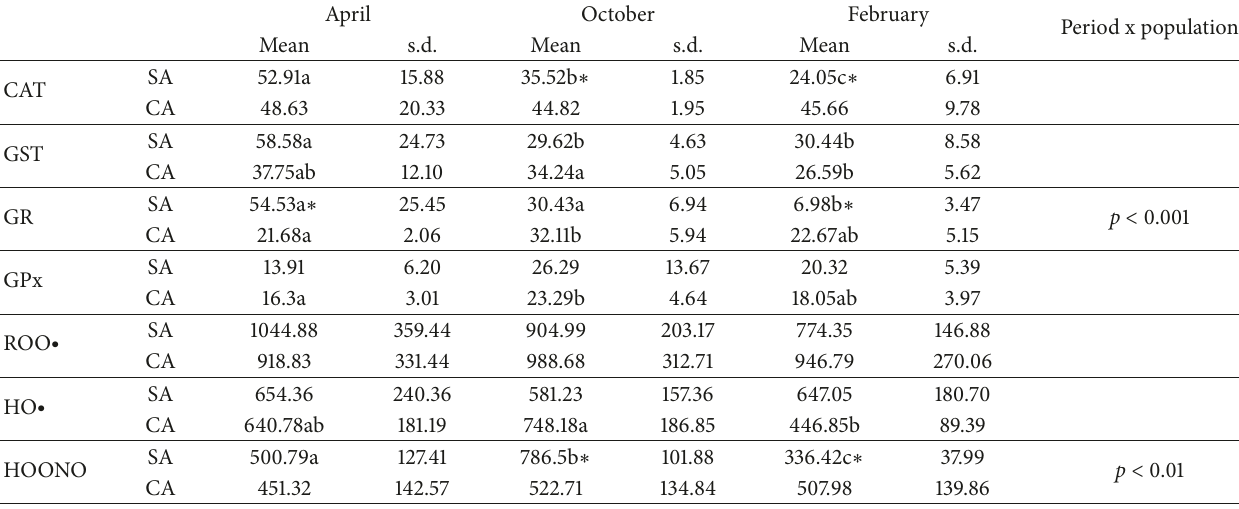
Table 1: Sampling periods’ variations of biomarkers (mean values ± standard deviations, 𝑛 = 5 ) in Platynereis spp. population from Sant’Anna (SA, normal pH conditions) and Castello Aragonese (CA, acidified pH